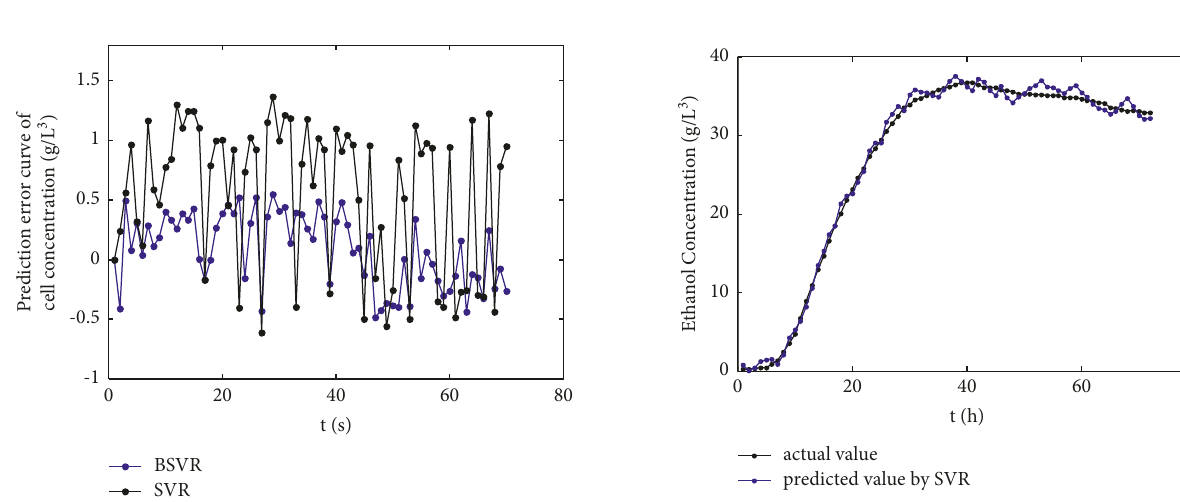
Figure 3: Error curve of cell concentration prediction.